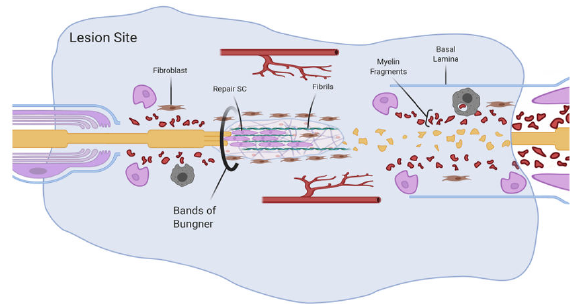
Figure 3. Schwann cells migrate onto a new matrix and onto cells and tissue, which confers direc- tionality. The figure was adapted from “Peripheral Nervous System (PNS) Myelin Structure” by BioRender.com (accessed on